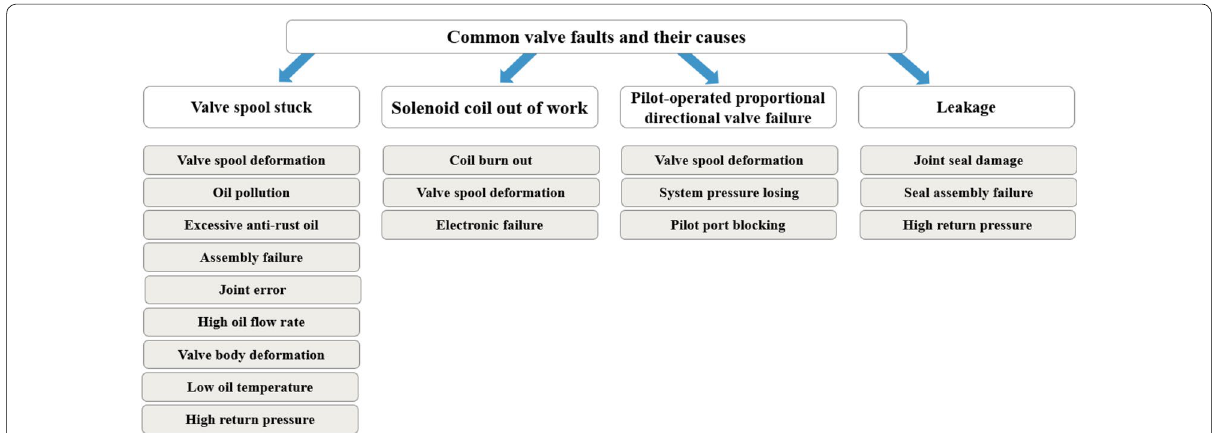
Figure 18 Common valve faults and their causes